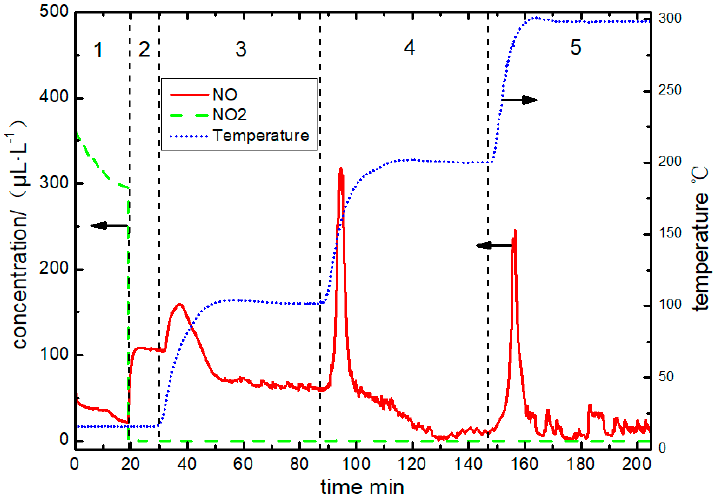
Figure 6. Effect of AC on NO 2 + NH 3.